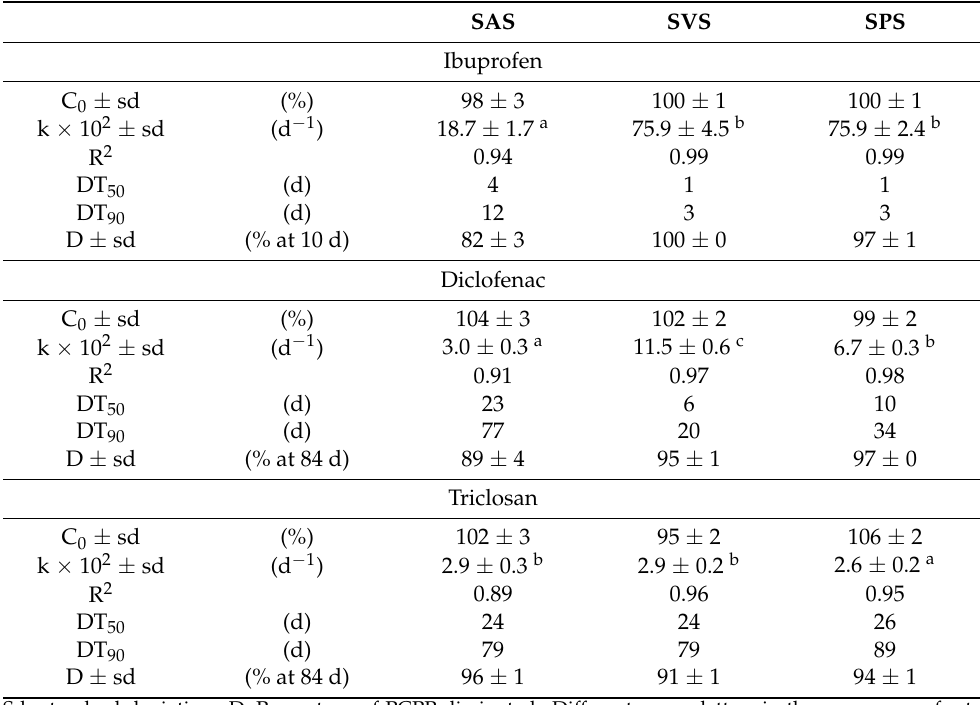
Table 3. Degradation parameters from the single first-order degradation model of each PPCP, in SAS, SVS and SPS biomixtures. SAS SVS SPS Ibuprofen C 0 ± sd (%) 98 ±